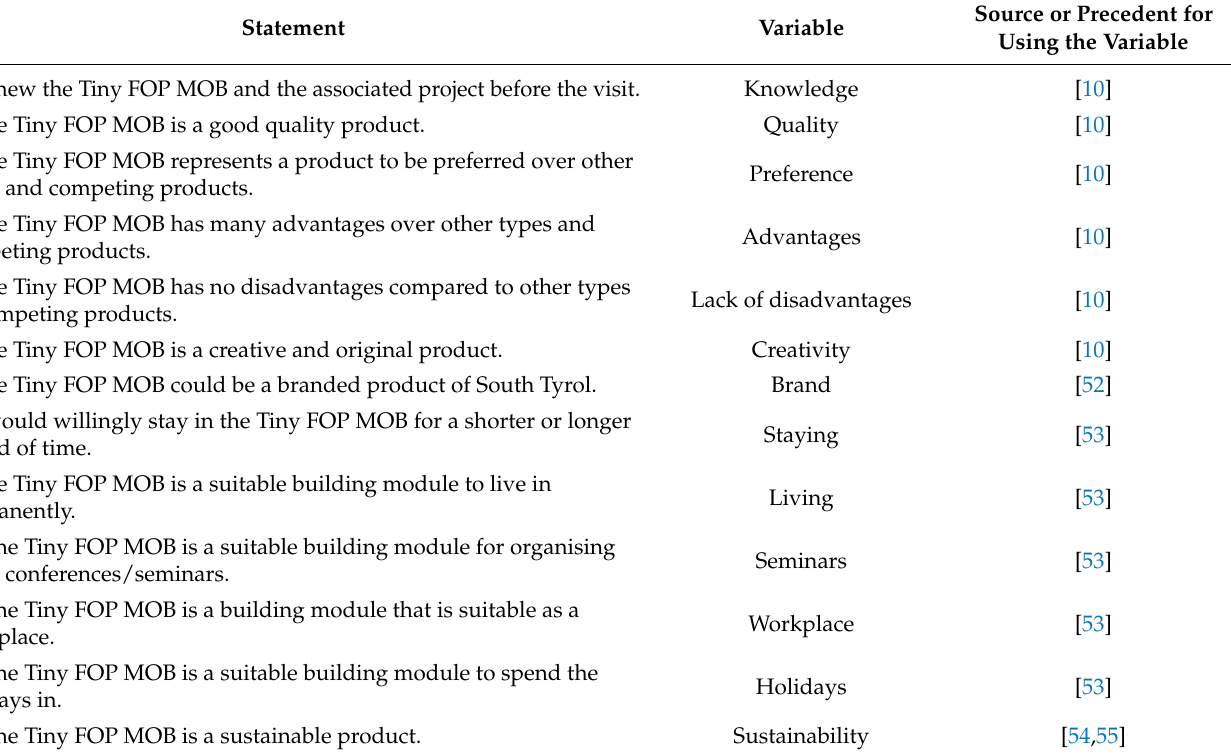
Table 2. Questionnaire’s list of statements and variable names related to knowledge, perception, quality and